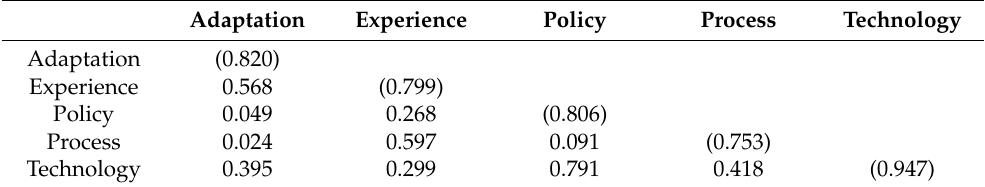
Table 5. Values obtained from the analysis.